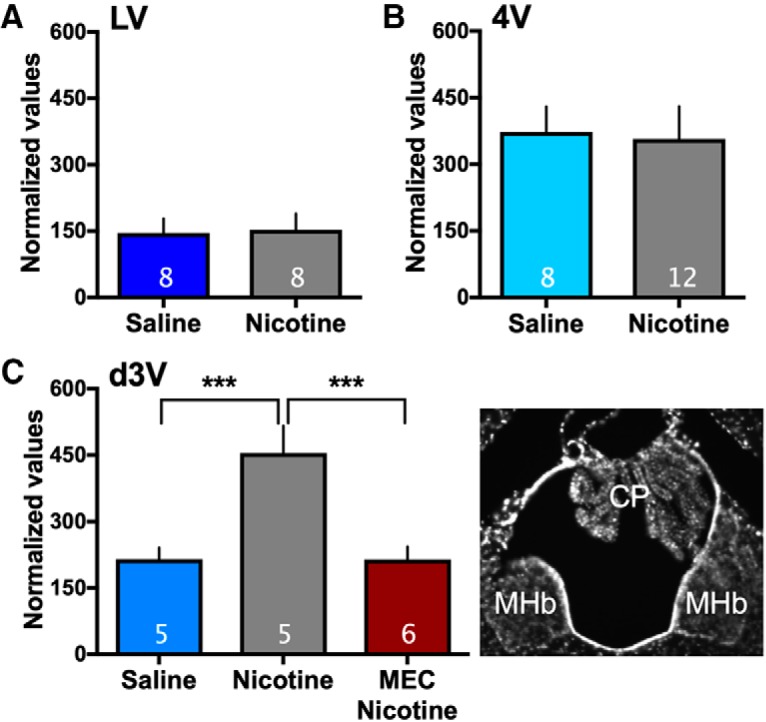
Transthyretin expression in the choroid plexus with saline or nicotine self-administration. Expression of choroid plexus specific transthyretin mRNA was examined in rats self-administering saline or nicotine (n = 5–12/group, specific number per group denoted on each bar). A, In the lateral ventricle (LV), differences were not found between groups in transthyretin expression. B, In the fourth ventricle (4V), no differences were found in transthyretin expression. C, In the dorsal third ventricle (d3V), significant upregulation of transthyretin was found with nicotine self-administration, an effect that was reversed with pretreatment of mecamylamine (MEC) before nicotine self-administration; ***p < 0.001. The photomicrograph on the right displays the localization of the choroid plexus (CP) in the d3V, which is in proximity to the habenula (Hb). Central tendency (mean) and variation (SEM) values for each are as follows: LV - Saline: 145.9 ± 32.23; Nicotine: 152.9 ± 36.57; 4V - Saline: 372.8 ± 57.27; Nicotine: 357.3 ± 73.58; d3V - Saline: 214.5 ± 25.81; Nicotine: 455.0 ± 61.43; and Mecamylamine/Nicotine: 214.3 ± 29.21. For all of the above, expression data were normalized to expression of β-actin. Data represent mean normalized values ± SEM.